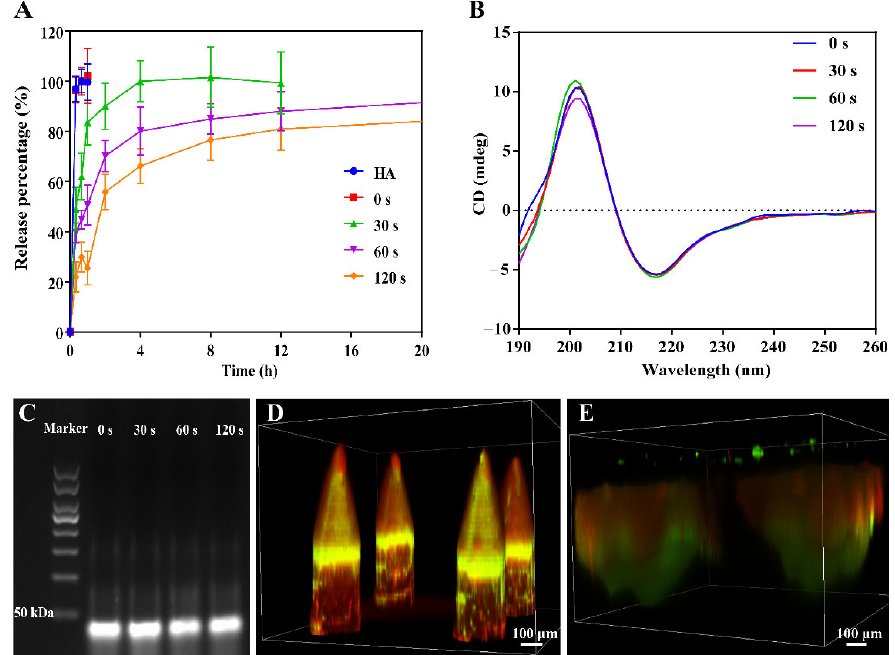
Figure 4. Drugs loading and release. ( A ) Release of model drug BSA ‐ FITC from the needle tips of the separable MN. ( B ) CD spectra of TCZ after UV irradiation. ( C ) Agarose gel electrophoresis of Apt1 ‐ 67 after UV irradiation. ( D ) CLSM image of TCZ ‐ FITC and Apt1 ‐ 67 ‐ cy5 loaded separable MN. ( E ) Ex vivo examination of the mouse skin after application of TCZ ‐ FITC and Apt1 ‐ 67 ‐ cy5 loaded MN.